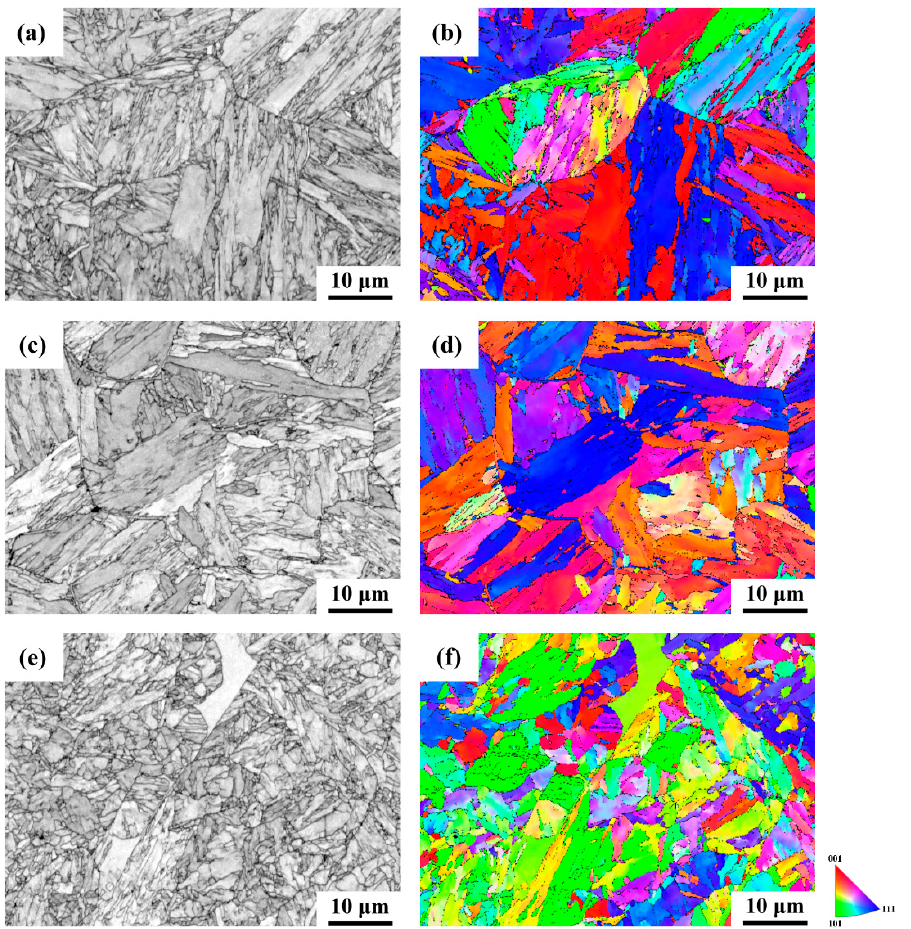
Figure 3. ( a , b ) WT, ( c , d ) WT-820T, ( e , f ) WT-890T. ( a , c , e ) Scanning electron micrographs; ( b , d , f ) the corresponding inverse pole figure (IPF) maps.